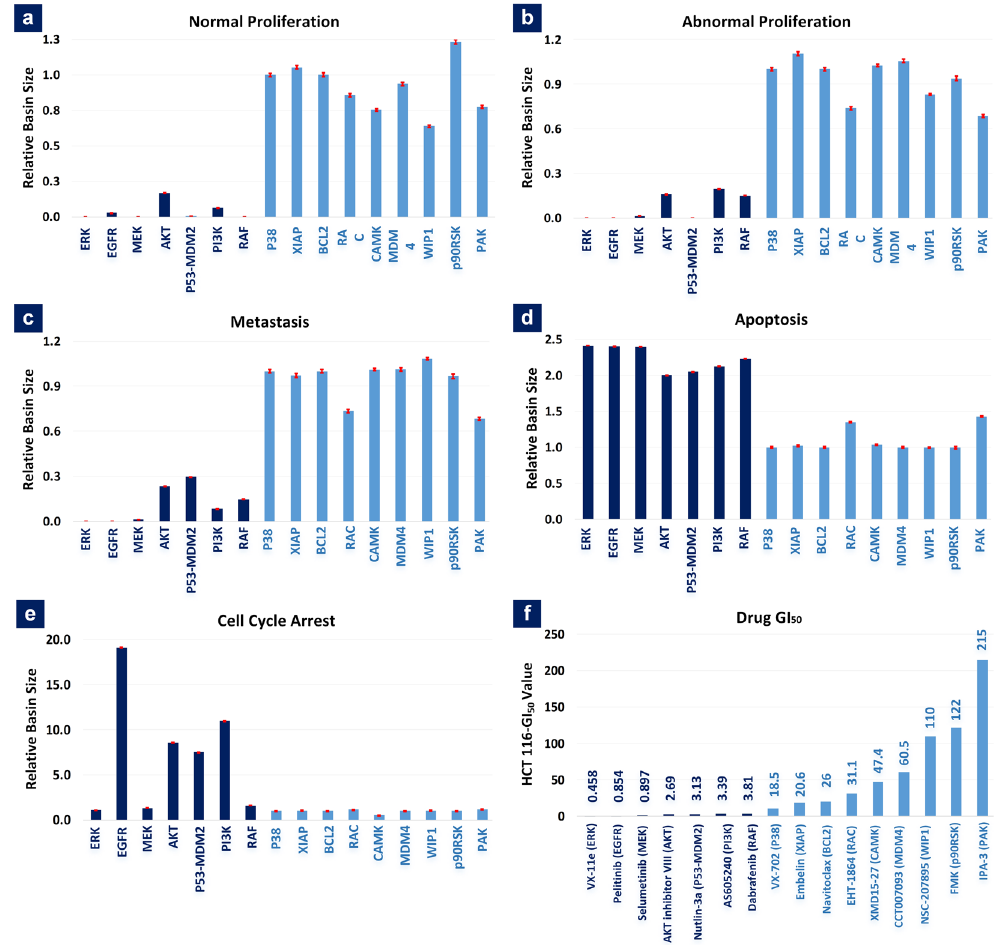
Figure 6. In silico Drug Screening in ATLANTIS. Relative basin sizes of ( a ) normal proliferation, ( b ) abnormal proliferation, ( c ) metastasis, ( d ) apoptosis and ( e ) cell cycle arrest after inhibition of 16 different drug targets in HCT-116 representative biomolecular network. ( f ) GI 50 values of cells upon inhibition of various drug targets. The x-axis in 6a-e represents various drug targets that were inhibited and 6 f shows the drug-target combinations. The y-axis in 6a-e represents relative basin sizes for each cell fate. The basin size values are relative to the propensity of the cell fate in the untreated HCT-116 cell network